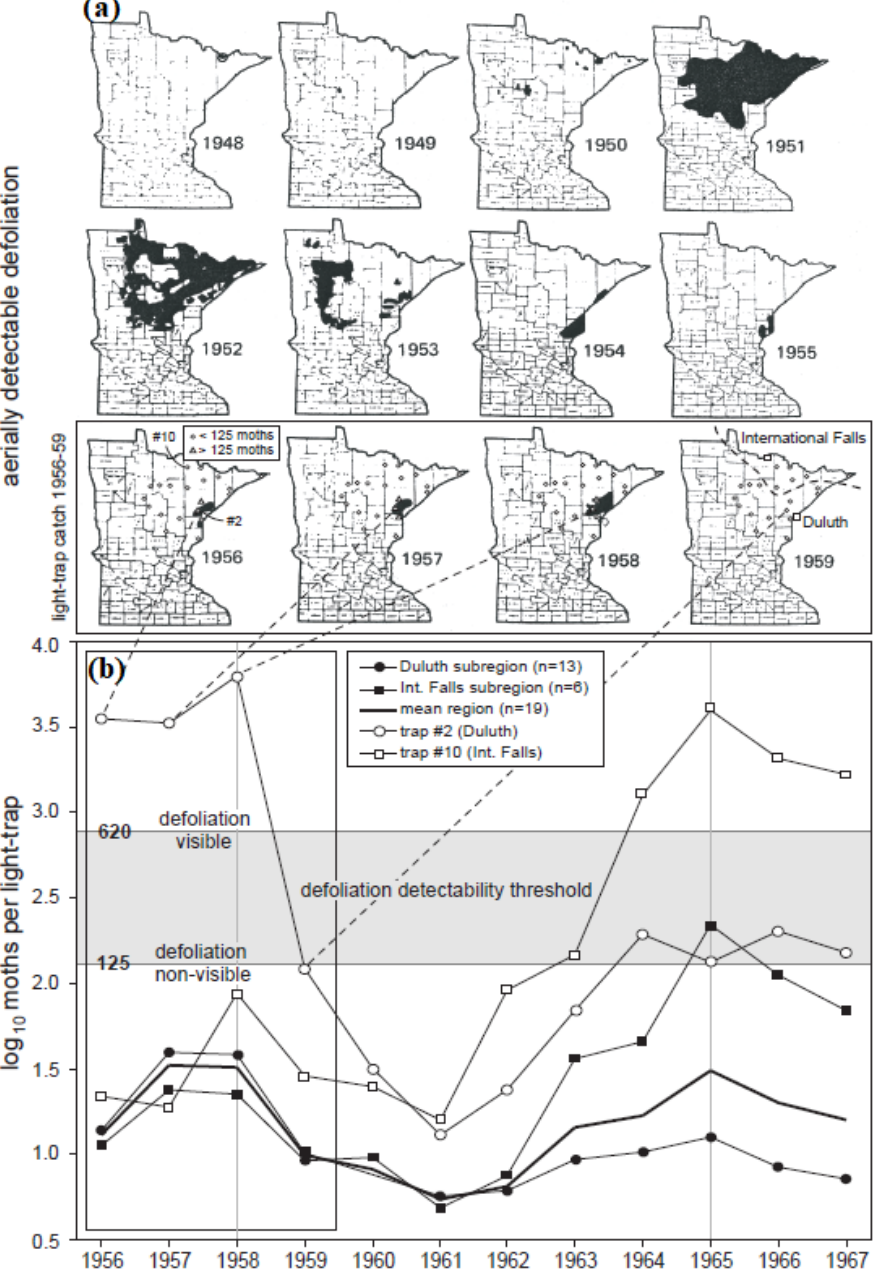
Figure 4. Hodson’s (1977) ( a ) defoliation maps and ( b ) light ‐ trap data for Minnesota.